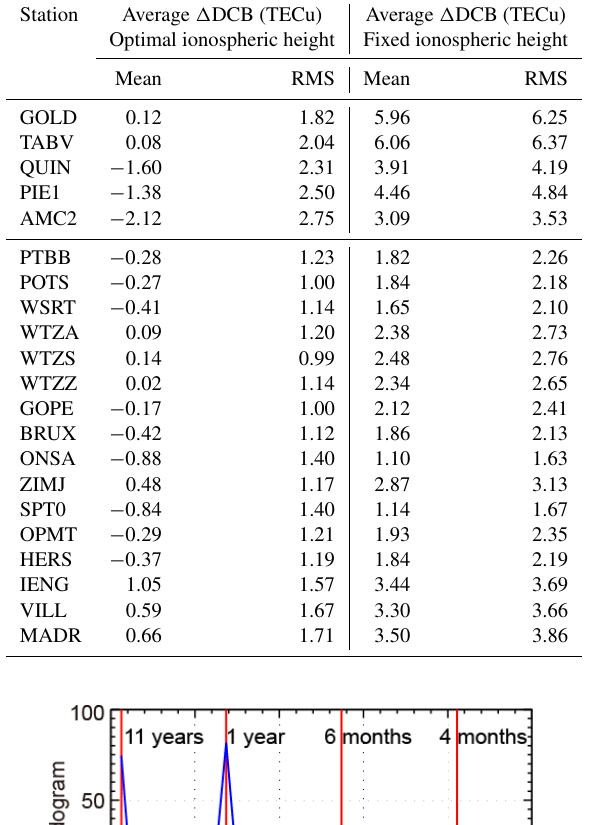
Table 2. Statistical results of mean and RMS of average (cid:49) DCB in 2014.